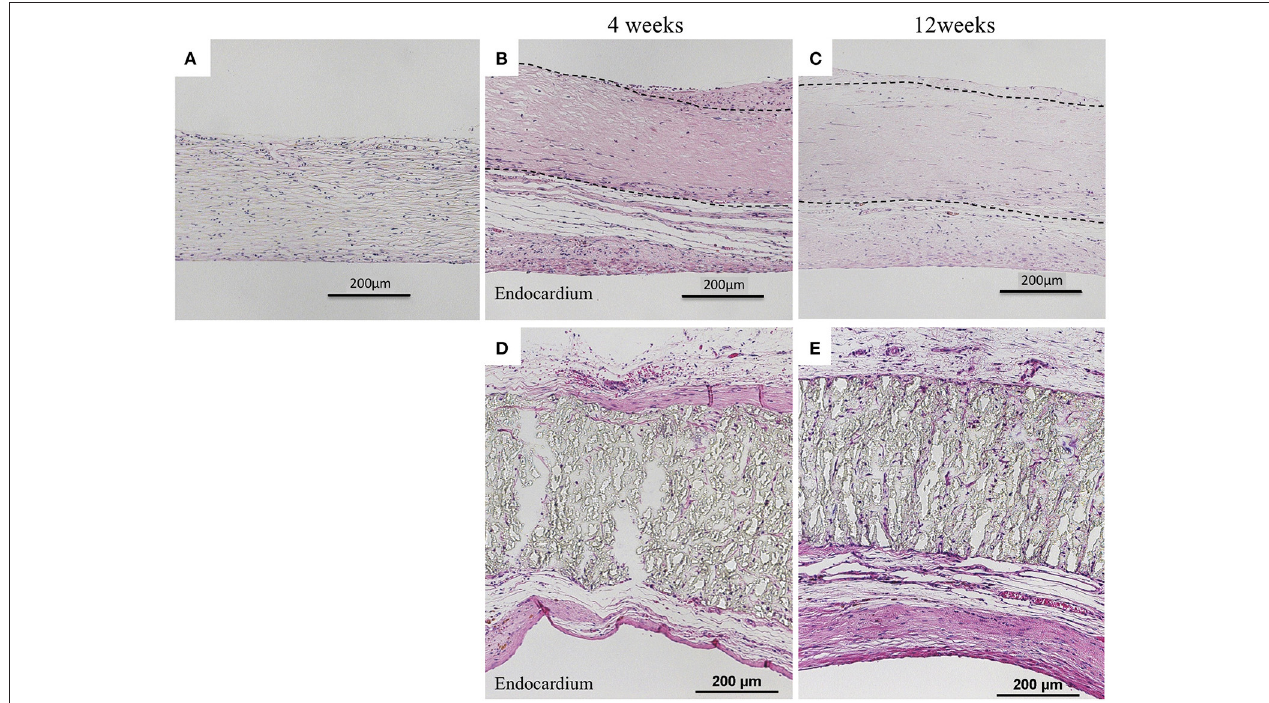
FIGURE 4 | Results of histological examination (H&E staining). (A) Image before implantation of biosheet. Images at 4 and 12 weeks after implantation of biosheets (B,C) and ePTFE (D,E) patches. Biosheets exhibited cellular and capillary ingrowth.